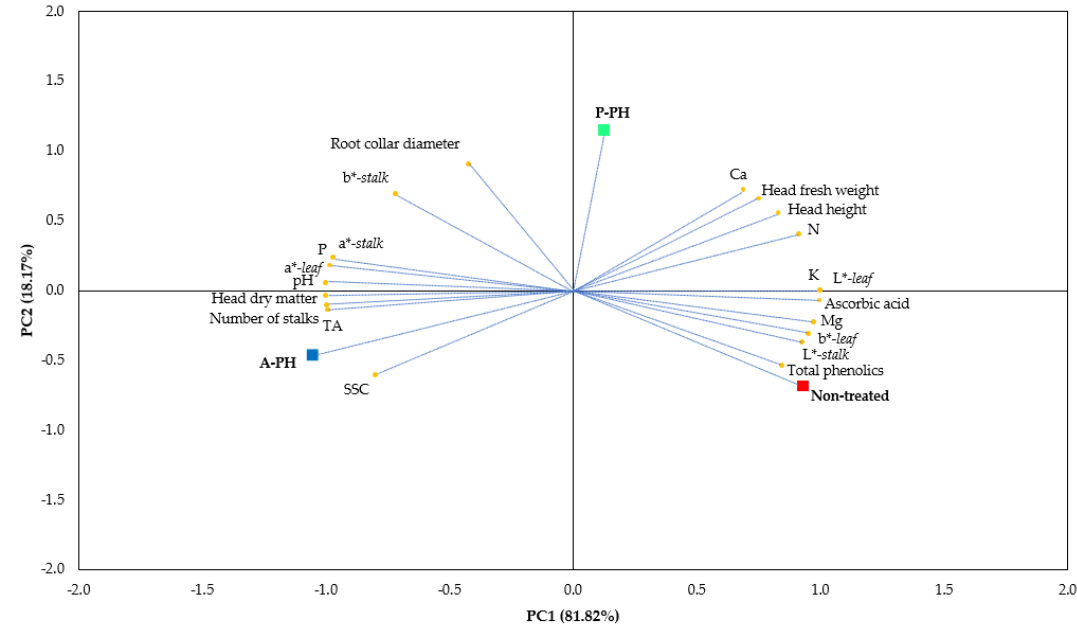
Figure 1. Principal component loading plot and scores of the principal component analysis (PCA) of the yield and morphological components, mineral composition (N, P, K, Ca, and Mg), head dry matter, soluble solids content (SSC), pH, titratable acidity (TA), bioactive molecules (ascorbic acid and total phenolics) and stalks and leaves color traits of celery as a function of animal or plant-derived protein hydrolysates. A-PH = animal-derived PH; P-PH = plant-derived PH. N = nitrogen; P = phosphorus; K = potassium; Ca = calcium; Mg = magnesium; SSC = soluble solid content; TA = titratable acidity.